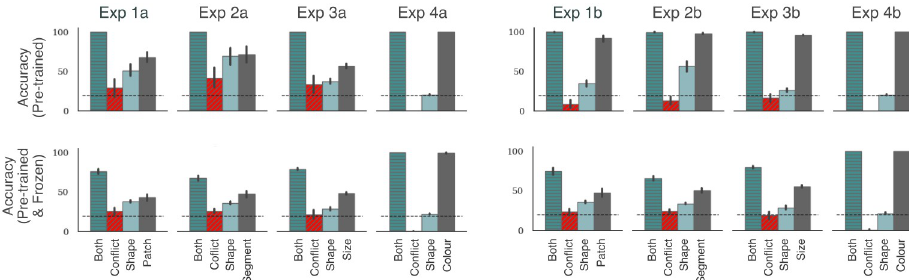
Fig 4. Results for pre-training on a dataset with a shape-bias. The first row shows results when the CNN was pre- trained on the Style-transfer ImageNet [37] and allowed to learn throughout the network. The second row shows results of the same network when weights for all convolution layers are frozen. First column shows results when both features are equally likely (Experiments 1a, 2a, 3a and 4a) while the second column shows results when the non-shape cue is more predictive (Experiments 1b, 2b, 3b and 4b). In all panels, we again observed a large difference between the Both and Conflict conditions, indicating that despite pre-training, models relied heavily on the non-shape cue to classify